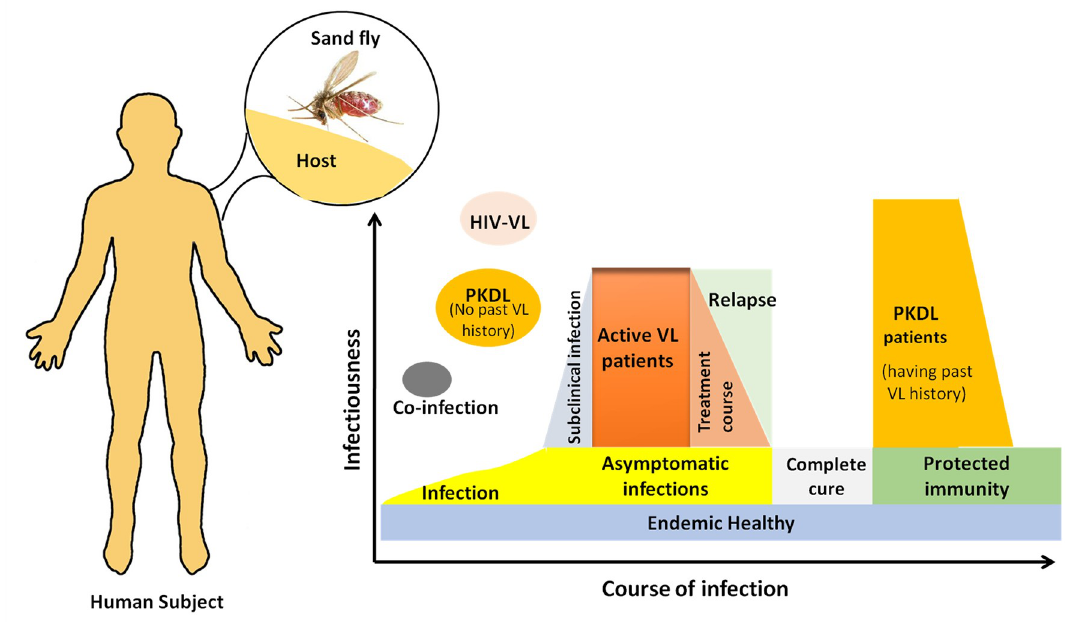
Fig 1. Dynamics of human infectious reservoirs for VL. Human infection is initiated when an infected female P . argentipes injects L . donovani parasites during a blood meal. Most infections do not lead to clinical symptoms and are suppressed or eliminated by the innate or adaptive immunity. Only a fraction of infected, asymptomatic subjects progress to clinical VL disease. After treatment of clinical infection, most patients develop protective immunity against the disease. Approximatly 1% to 10% of former VL patients may develop a chronic cutaneous form called PKDL. PKDL without history of VL is rare. HIV positive individuals are more at risk of developing VL once infected and become important source of transmission due to their potentially high parasitic load. PKDL, post kala-azar dermal leishmaniasis; VL, visceral